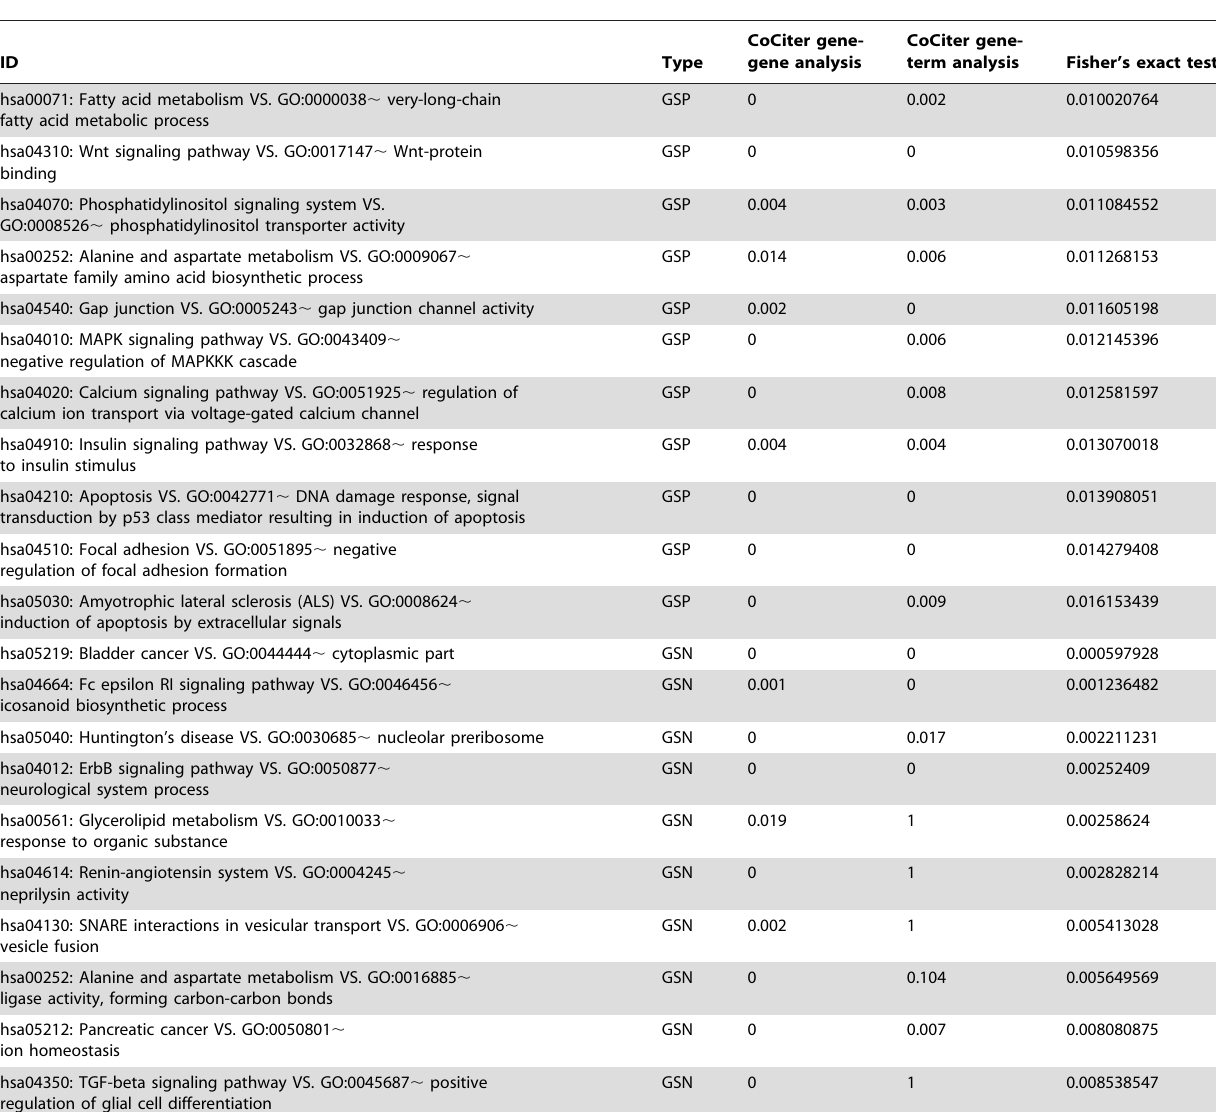
Table 4. Significance of association for 10 GSP and GSN gene and term sets detected by CoCiter or the GO-based